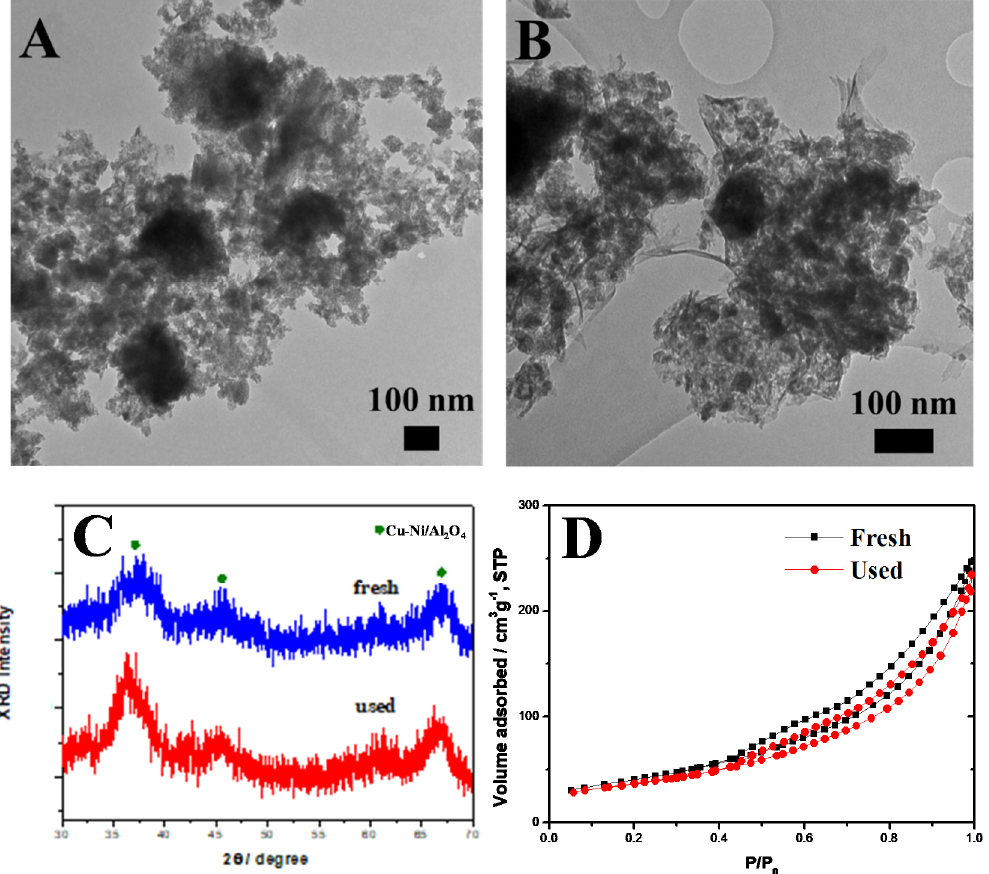
Figure 9. TEM images of Cu-Ni/Al 2 O 4 catalyst ( A ) fresh catalyst and ( B ) after POM test. ( C ) XRD plots and ( D ) nitrogen adsorption-desorption isotherms of materials shown in ( A , B